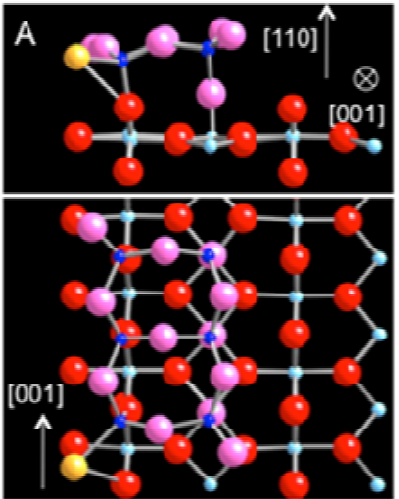
Figure 5. DFT calculation of Au adsorbed at the 3-coordinated Ti site of the dot defect, ) on TiO modeled as (TiO 2 6 2